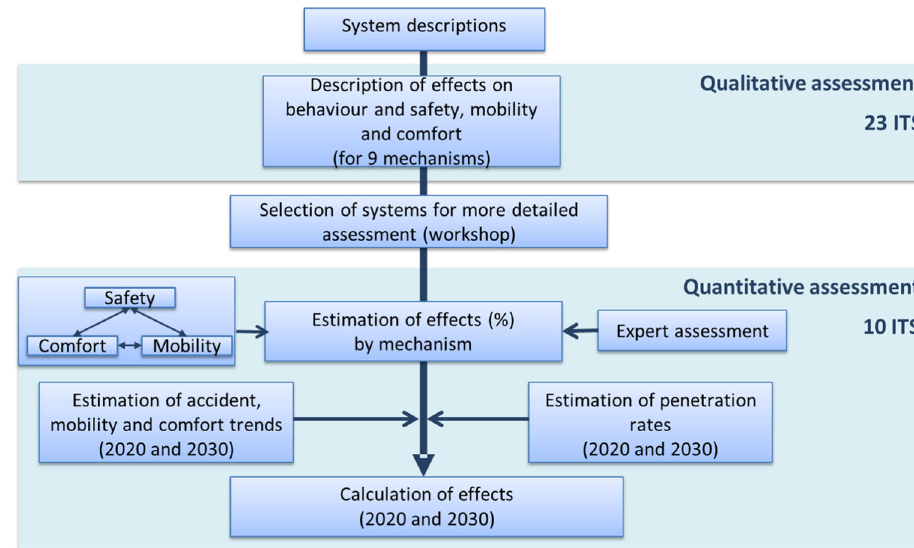
Fig. 4 Steps in applying the